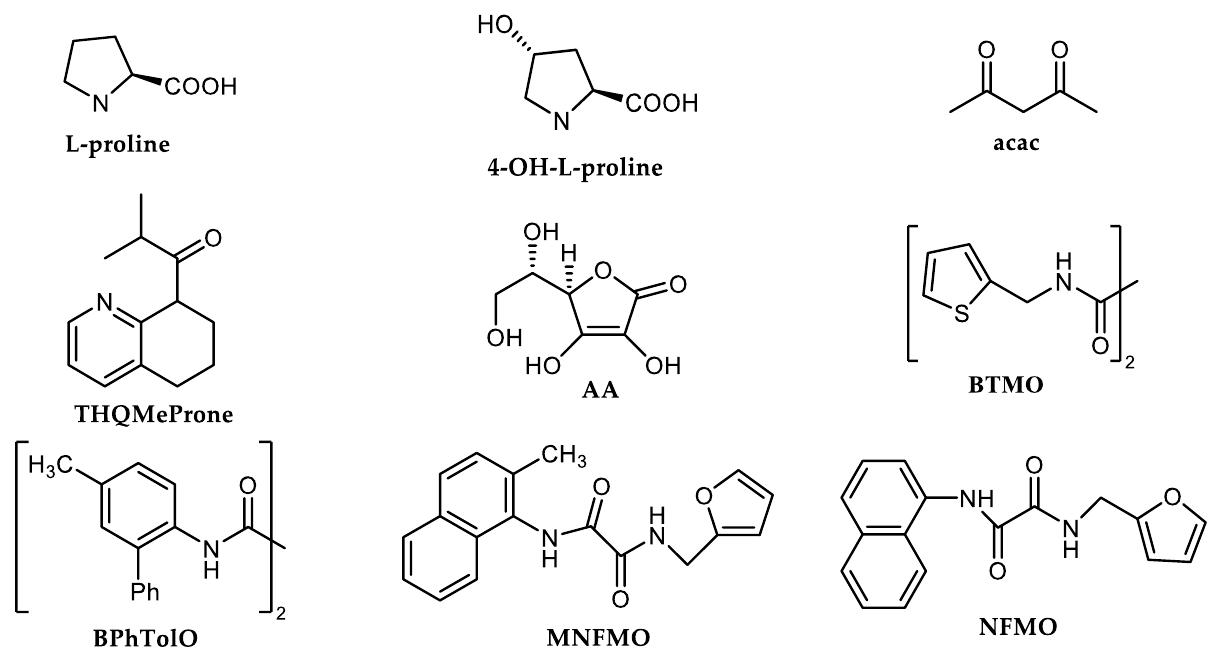
Figure 1. Structures of ligands applicable for converting aryl halides to the corresponding anilines [35 – 37,44 –